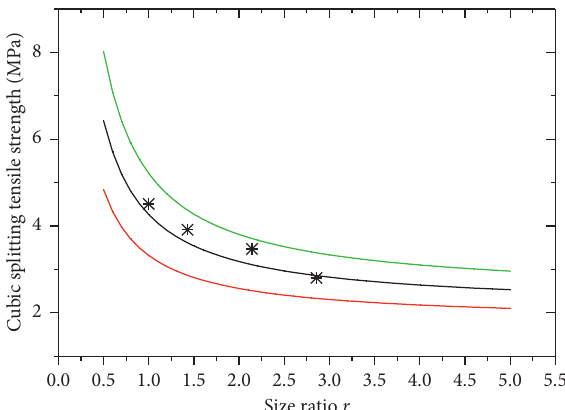
Figure 8: Fitting curves of size effect laws for splitting tensile strengths, respectively. In Figure 7, the black curves and the scatter points indicated by “ ∗ ” are obtained by equation (23) and the data in the fifth column of Table 5.